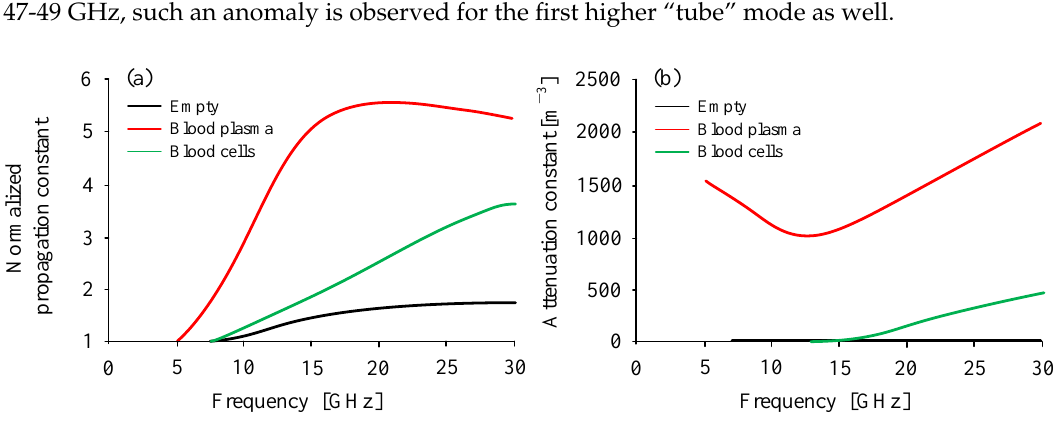
Figure 4. Normalized propagation constant h′/k ( a ) and attenuation constant h′′ ( b ) as functions of frequency for the fundamental “core” mode in an empty waveguide or that filled with blood components; r = 1 mm, R = 5 mm.